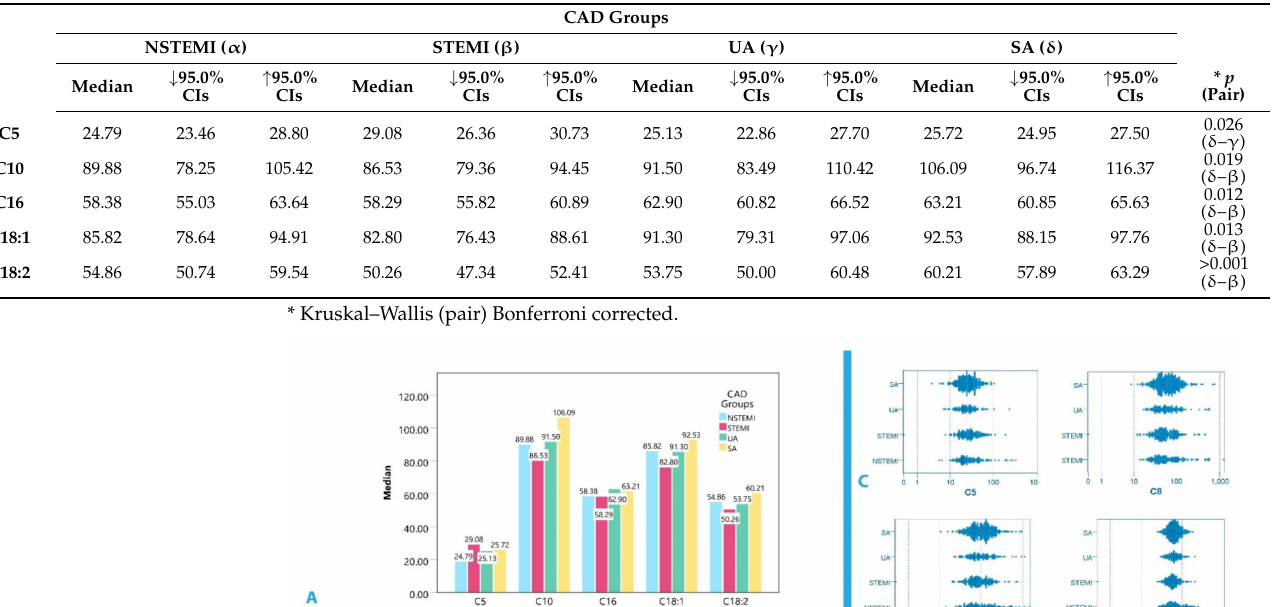
Table 5. Acylcarnitines C5, C10, C16, C18:1, and C18:2 levels ( µ g/L) with statistical significance according to the clinical presentation of CAD.